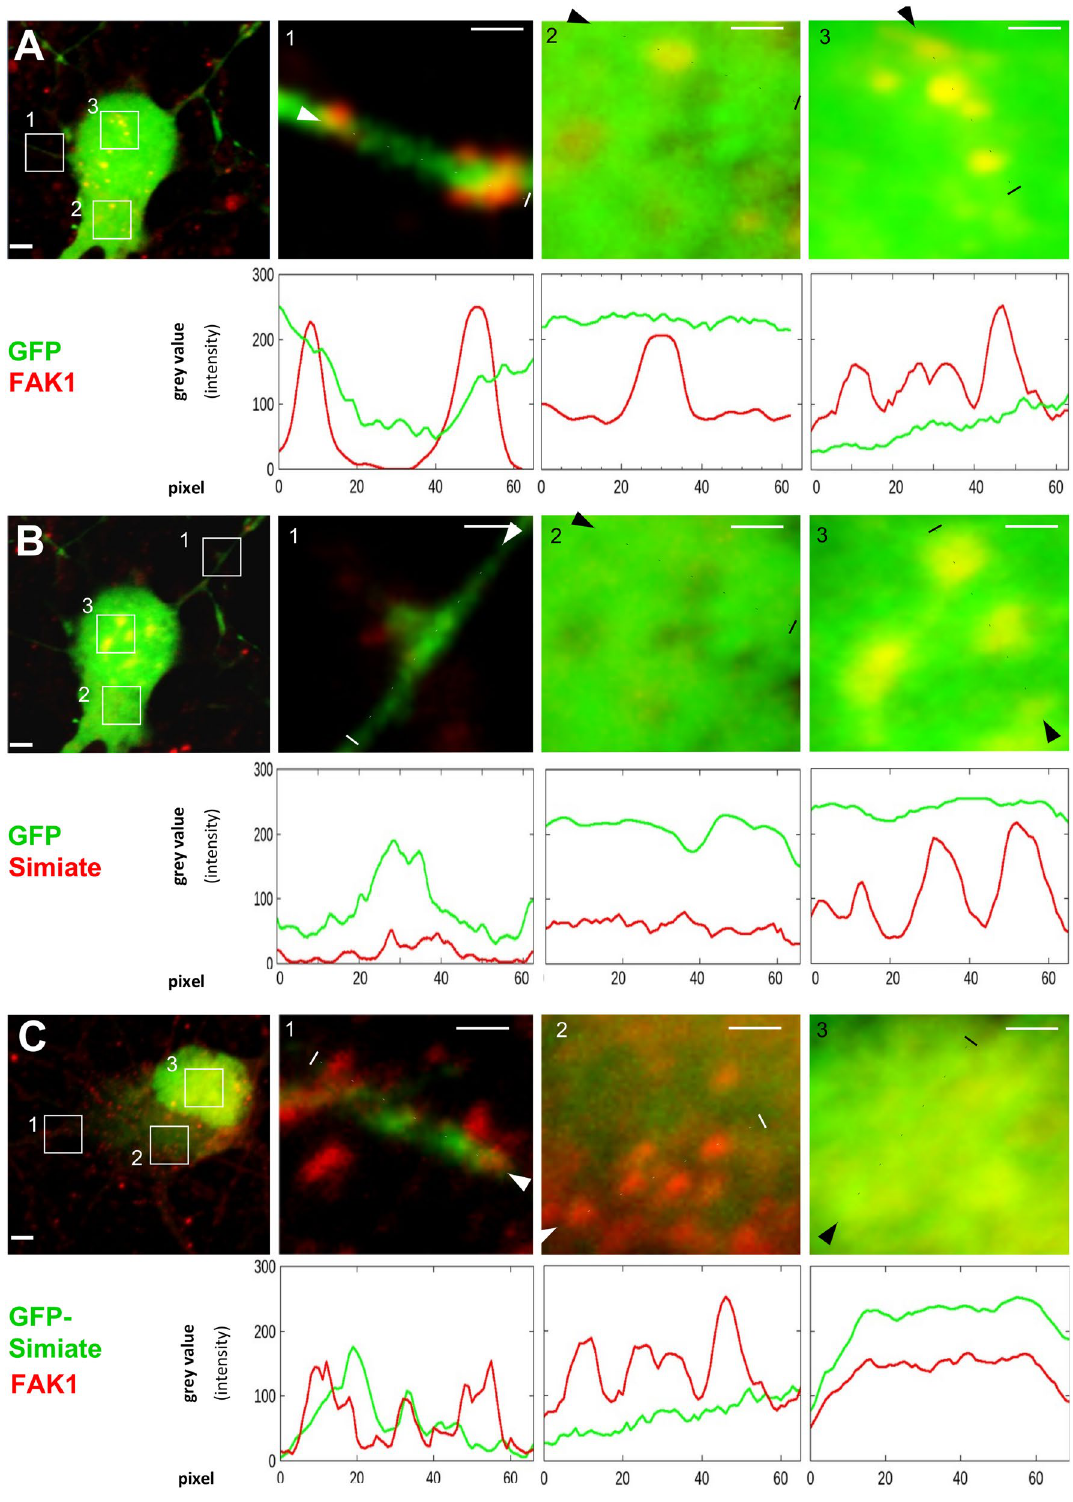
Figure 6. Alterations in the localisation of endogenous FAK1 and Simiate following expression of recombinant constructs (part 1). The pictures show representative micrographs of div 8 primary hippocampal neurons after over-night expression of GFP constructs (cp. Fig. 5). For each condition, a neuron and magnifications of parts from a dendrite, from the soma and from the nucleus are shown. The respective areas are indicated by white boxes in the overview-picture on the left. Below each magnification, graphs illustrate the signal intensities as exemplary quantified with ImageJ software for each protein of interest. The results are derived from 2 to 4 experiments. Dotted lines indicate the line of measurement. Scale bars: 1 µm in the magnifications and 2 µm in the overview picture. All images are contrast enhanced to demonstrate the colocalisation of FAK1 and Simiate (yellow). ( A , B ) Expressed GFP shows no colocalisation with FAK1 or Simiate in dendrites, somata or nuclei. ( C ) GFP-Simiate attracts some endogenous FAK1 in dendrites, but not in the soma. A strong attraction is seen in the nucleus. Please also see Fig. 7 for further details on the other